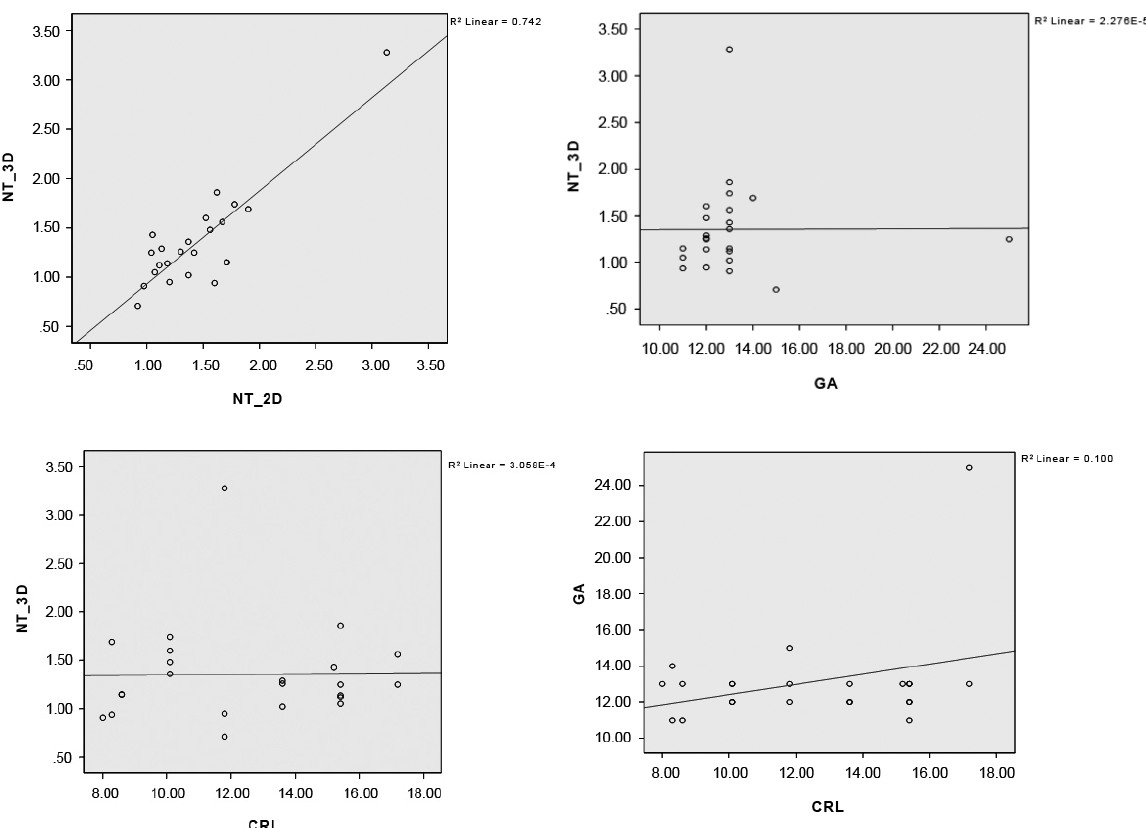
Fig. 9 - Correlation analysis among four different variables, (a) correlation between 3D and 2D nuchal translucency measurements, (b) correlation between 3D nuchal translucency and gestation week (GA), (c) correlation between 3D nuchal translucency and crown rump length (CRL), (d) correlation between gestation week and crown rump